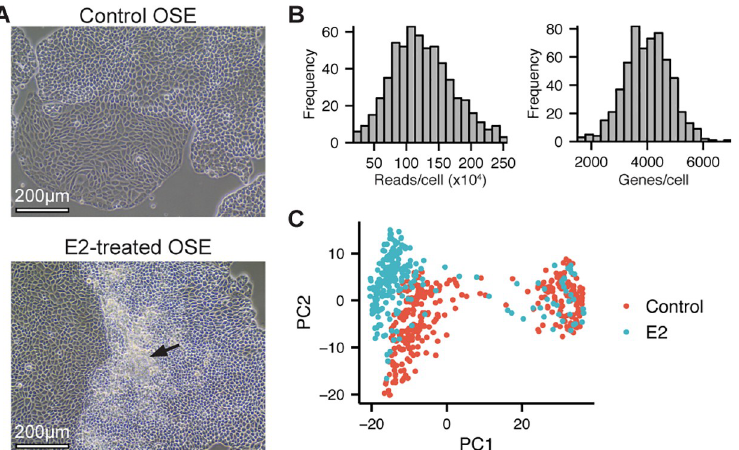
Fig 1. Single-cell profiling of control and dysplastic E2-treated OSE cells. (A) Phase-contrast images of control and E2-treated OSE cells. Scale-bar = 200 μ m. (B) Histogram of the number of reads (left) and genes (right) per cell following quality control filtering. (C) PCA of control and E2-treated cells from scRNA-Seq data. Data points represent individual cells and are coloured by treatment. 84.7% of total variance is accounted for by PC1 (75.6%) and PC2